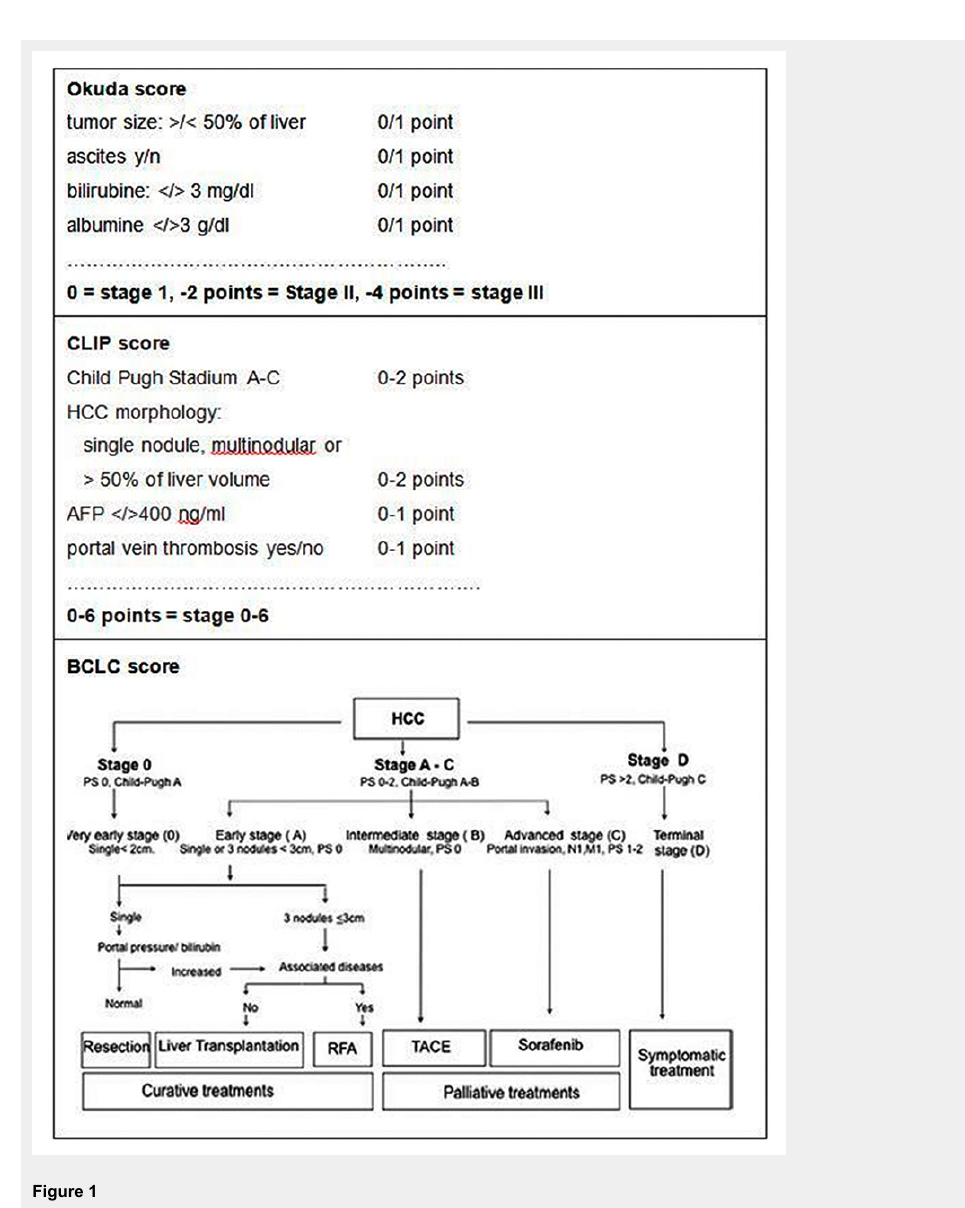
Figure 1 Principles of the Okuda, CLIP and BCLC scores as described in the literature [6, 12, 14]. AFP = alpha-foetoprotein; BCLC= Barcelona clinic liver cancer; CLIP = cancer of the liver Italian programme; RFA = radiofrequency ablation; TACE = transarterial